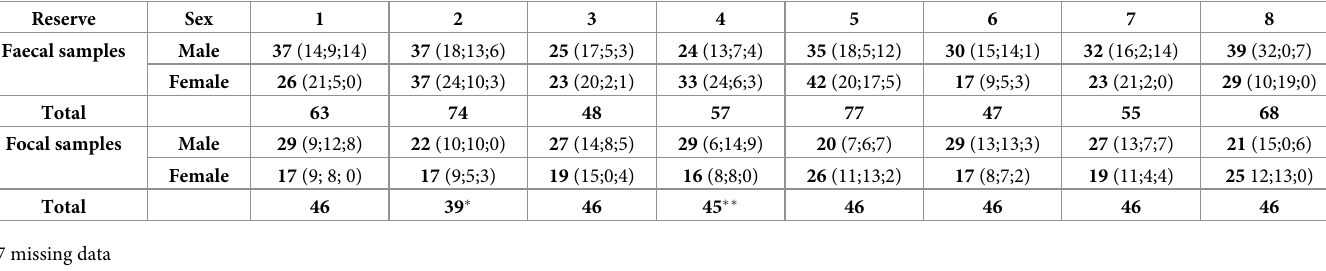
Table 6. Total number of faecal and focal (10-minute video) samples collected for each reserve separated according to sex and age (adult; sub-adult; juvenile) of the individual.